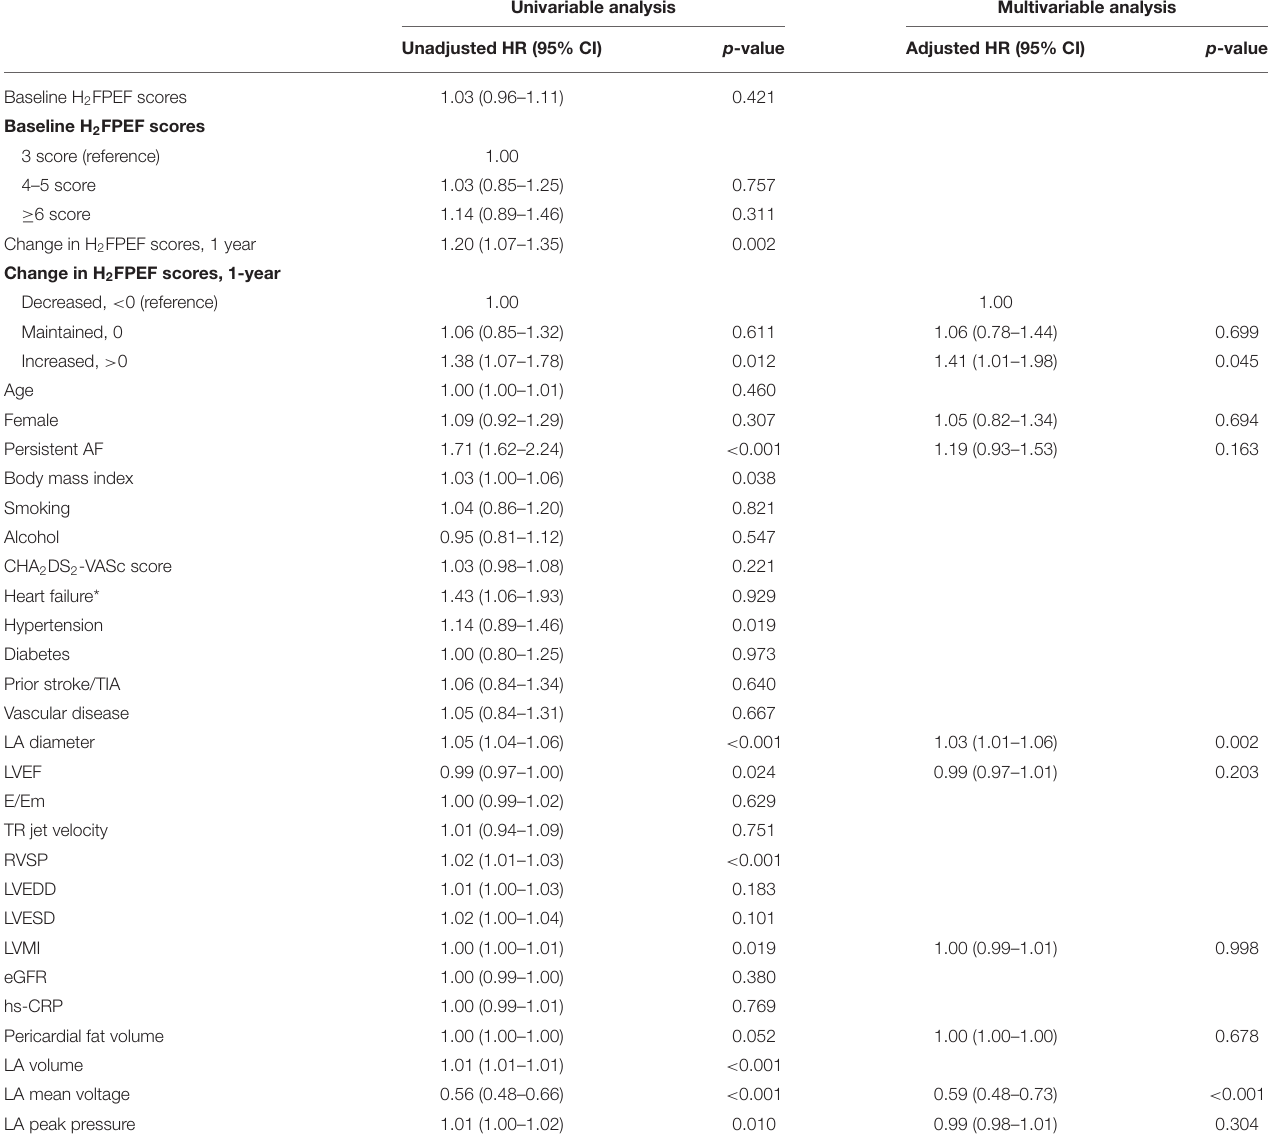
TABLE 5 | Cox regression analysis of the predictors of an AF recurrence after the AFCA, during the long-term follow up. Univariable analysis Multivariable